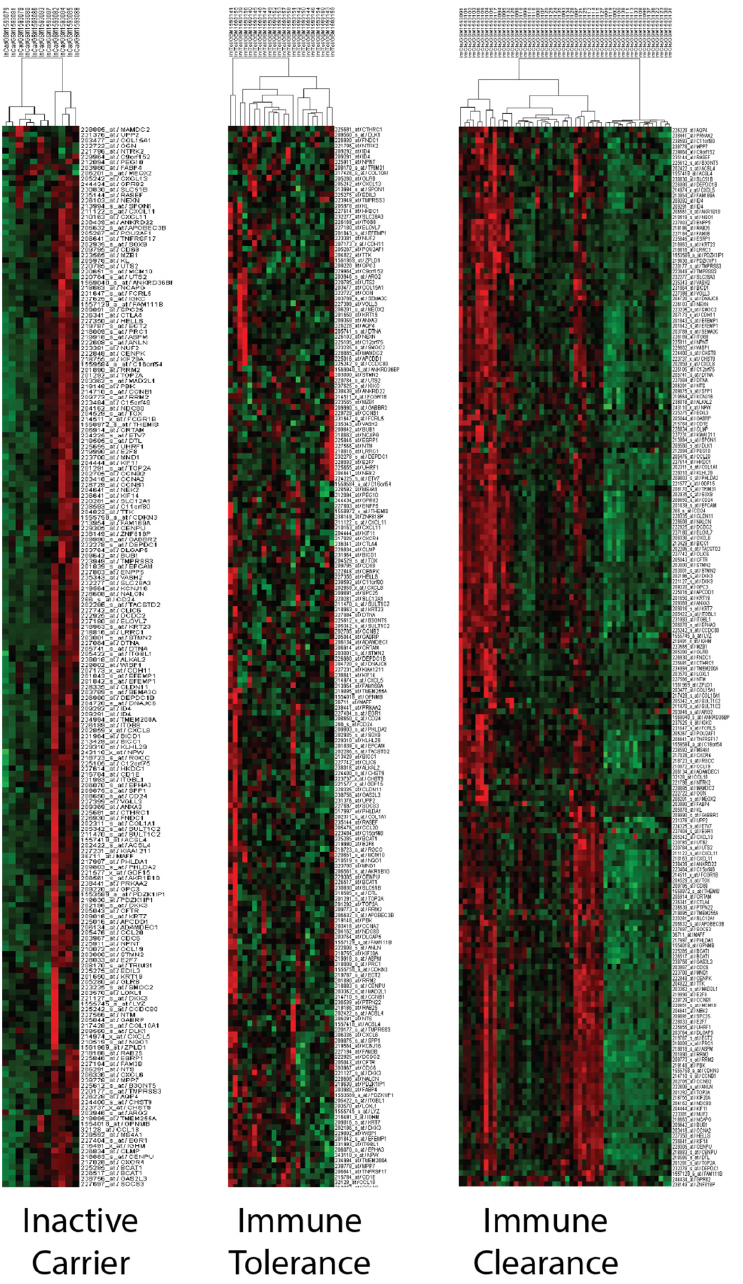
Figure 4. PCM1 ‐ based sub ‐ groups can be identified within inactive ‐ carrier and immune ‐ clearance phases but not in immune tolerance. Hierarchical clustering was performed with 195 probesets/176 genes separately in samples at inactive ‐ carrier, immune ‐ tolerance and immune ‐ clearance phases in GSE65359.